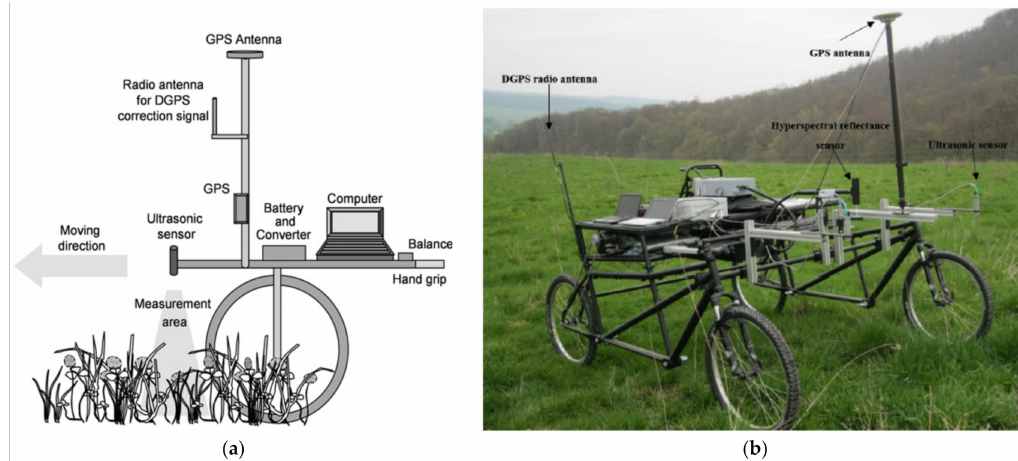
Figure 5. ( a ) Schematic of ‘on the go’ grass measurement system presented in Fricke et al., reprinted with permission from